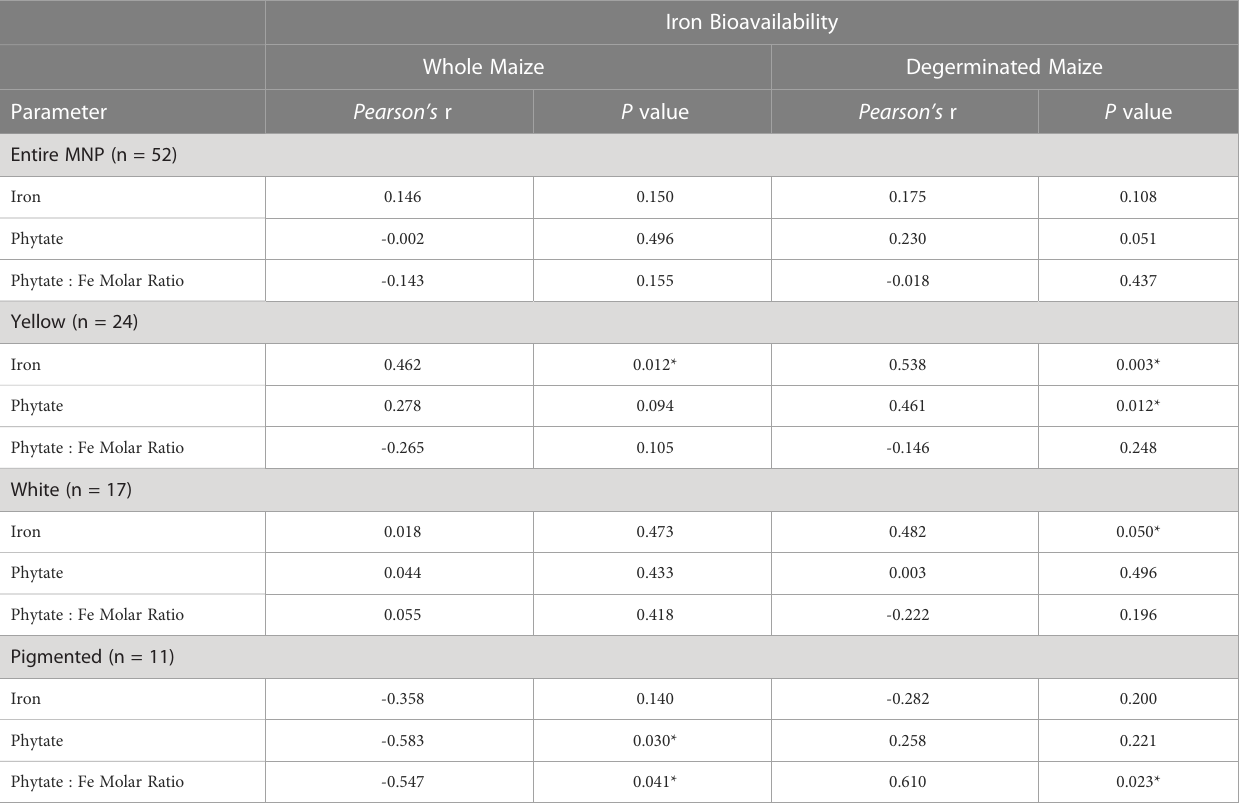
TABLE 1 Pearson correlations and associated P values between iron bioavailability, phytate and iron concentrations of the Maize Nutrition Panel (MNP) before and after removing the germ fraction (degerminated) 1 . Iron Bioavailability Whole